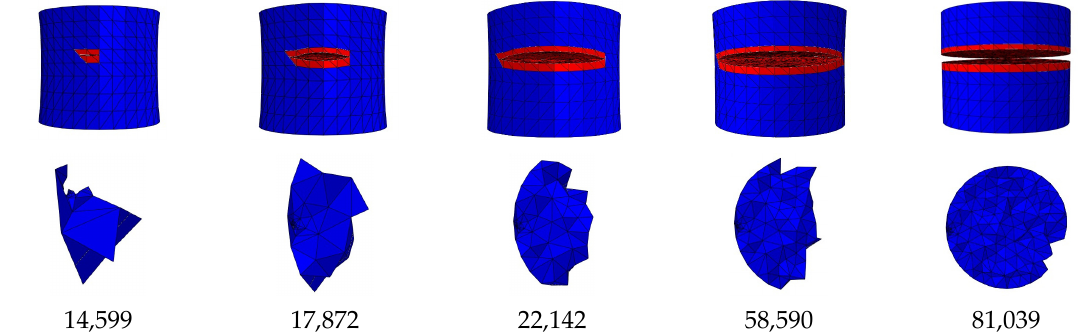
Figure 12. The geometry of the crack during its fatigue propagation as obtained numerically of Ti-6Al-4V at 800 MPa of 5 Hz.